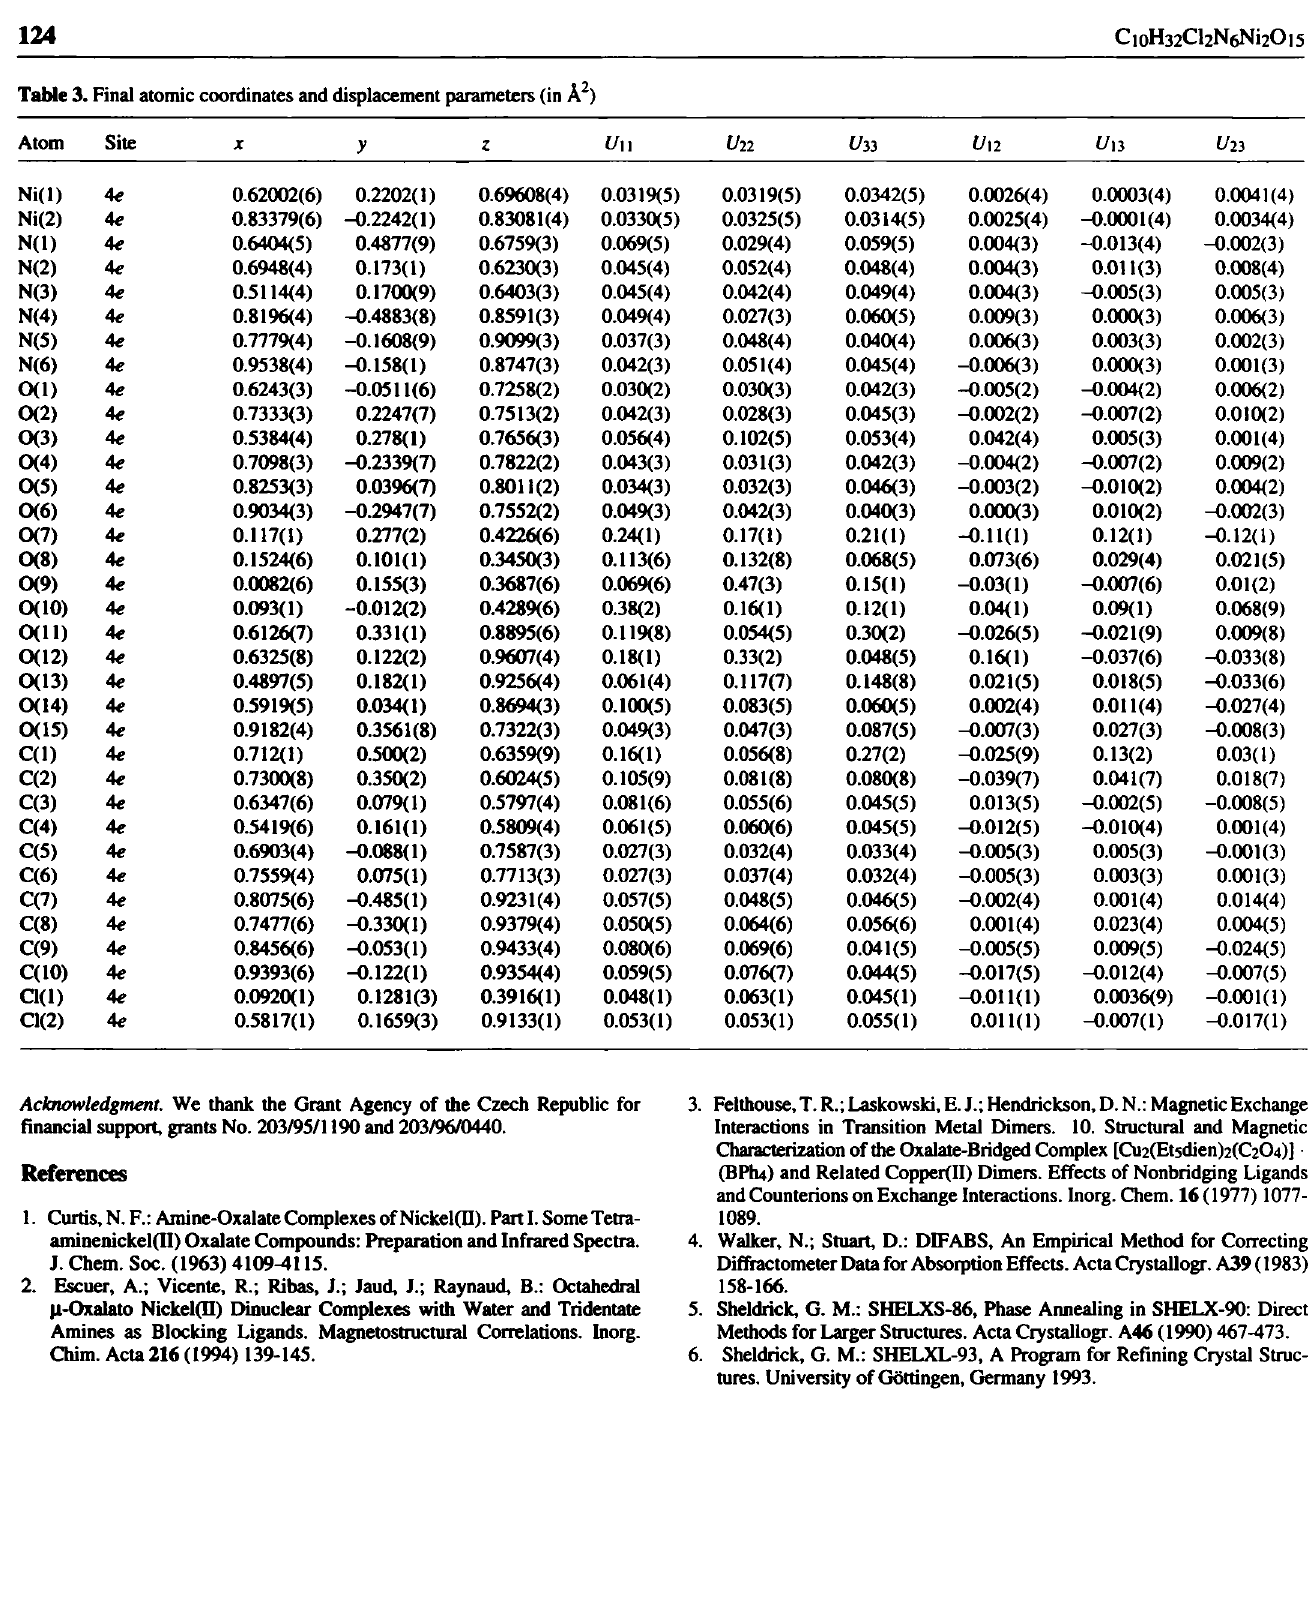
Table 3. Final atomic coordinates and displacement parameters (in Â 2